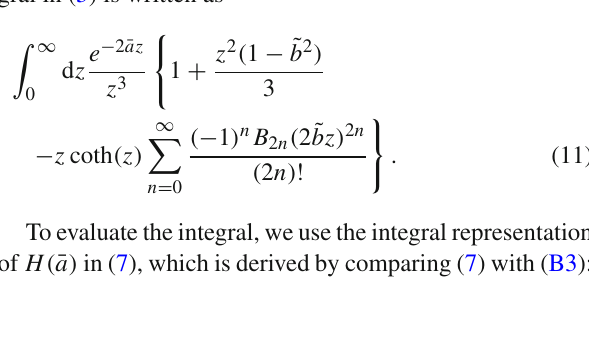
points of ¯ b = 0 . 5 ( E 0 = E c ), and the empty ones do the points of ¯ b = 1 ( E = 0 . 5 E c ). In (a), the horizontal cut at P Im 0 crosses the others at ¯ a = 0 . 034 , 0 . 068 , 0 . 14 , 0 . 30, corresponding to ( B / B , E / E ) = ( 15 , 0 . 37 ), ( 7 . 4 , 0 . 37 ), ( 3 . 6 , 0 . 36 ), ( 1 . 7 , 0 . 33 c c